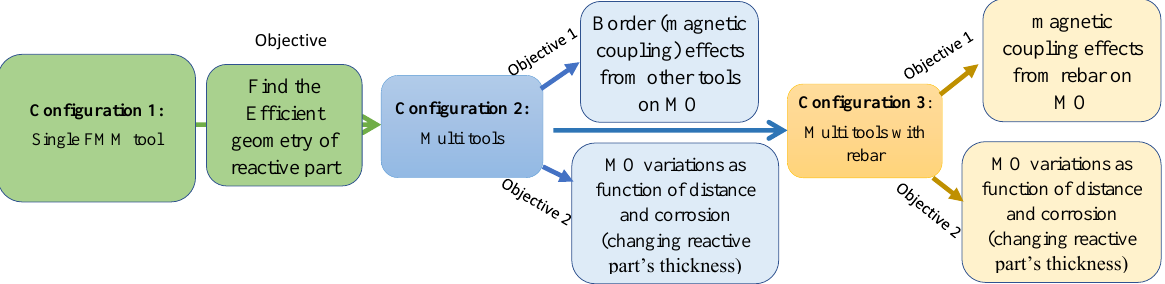
Figure 3. Numerical modeling steps and the associated objectives in each